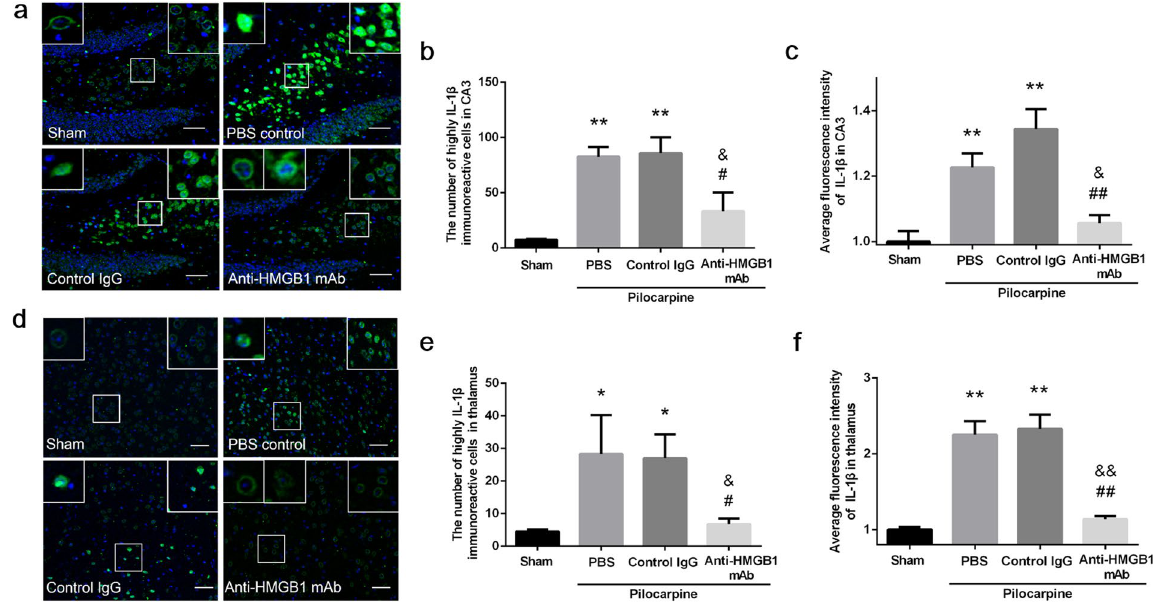
Figure 6. Expression of IL-1 β in the CA3 hippocampal region and the thalamus of mice under acute status epilepticus. Anti-HMGB1 mAb, control IgG or PBS was administered intravenously when mice reach Racine stage 5 by pilocarpine administration and sacrificed 4 h later. The brains were fixed by formalin and paraffin- embedded sections were stained with anti-IL-1 β antibody. The hippocampal CA3 ( a ) and thalamus region ( d ) were under observation. The number of highly IL-1 β immunoreactive cells ( b ) and the fluorescence intensity ( c ) were analyzed in hippocampus CA3. ** p < 0.01 compared with the sham group. & p < 0.05 compared with the PBS group. ## p < 0.01, # p < 0.05 compared with the control IgG group. The results are shown as the means ± SEM of 8 mice. The number of highly IL-1 β immunoreactive cells ( e ) and the fluorescence intensity ( f ) were analyzed in thalamus. The results are shown as the means ± SEM of 8 mice. ** p < 0.01, * p < 0.05 compared with sham group. && p < 0.01, & p < 0.05 compared with the PBS group. ## p < 0.01, # p < 0.05 compared with the control IgG group ( d ). Scale bars equal 50 μ